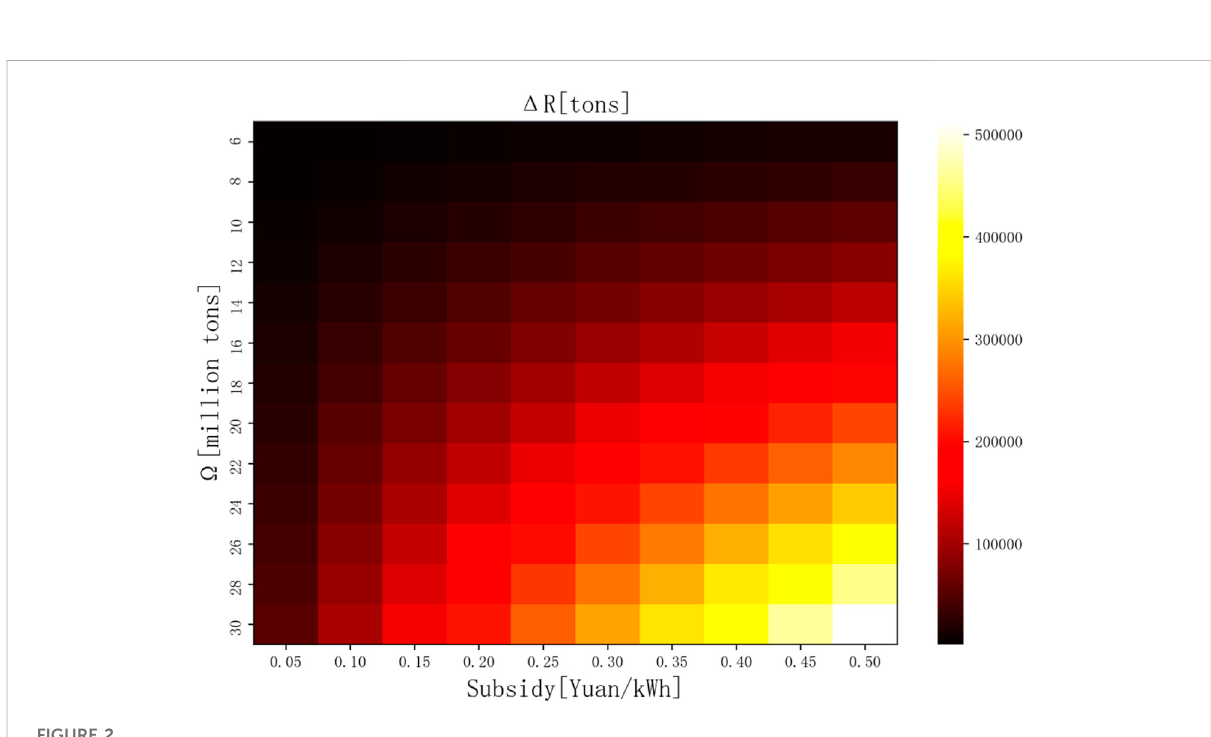
FIGURE 2 Carbon emissions of subsidy and carbon market combination